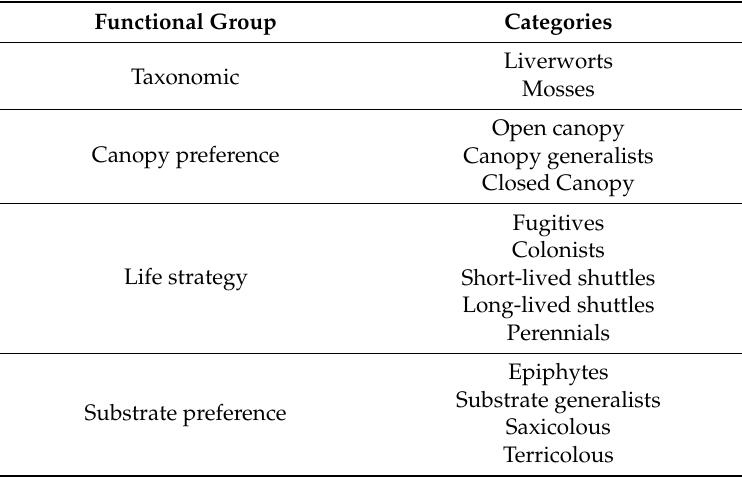
Table 2. Bryophyte functional groups classification used in the